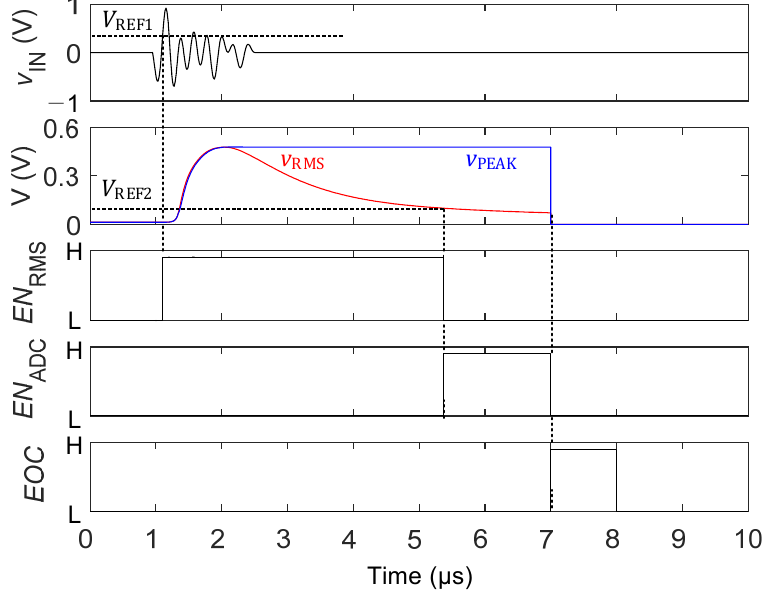
Figure 10. Simulated waveforms in the proposed monitoring system.